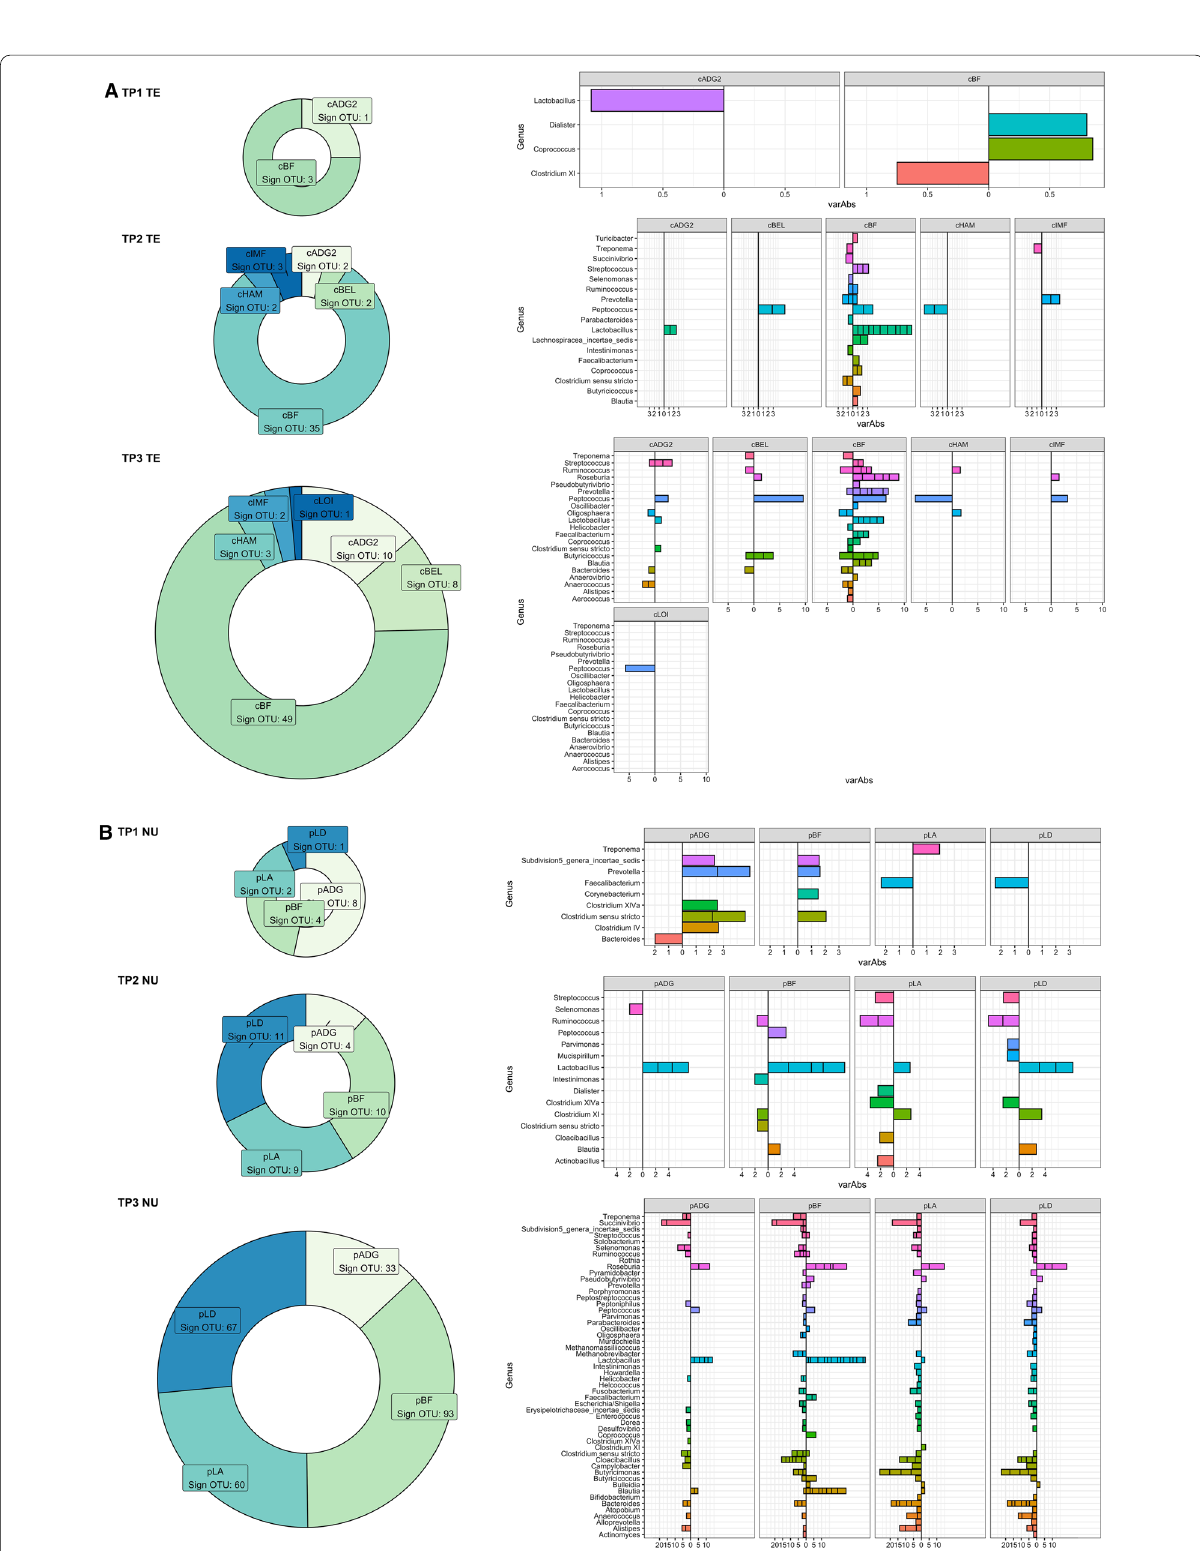
Fig. 6 Summary of significant trait OTUs associations. Significant OTU association for different traits (Left Panel) and variance absorbed by Genus (left panel, the direction of the bar indicates the sign of the effect: left negative, right positive) for Commercial (TE, a ), and Nucleus (NU, b ) at three time points: weaning (TP1), mid test (TP2), and off test (TP3) of the feeding